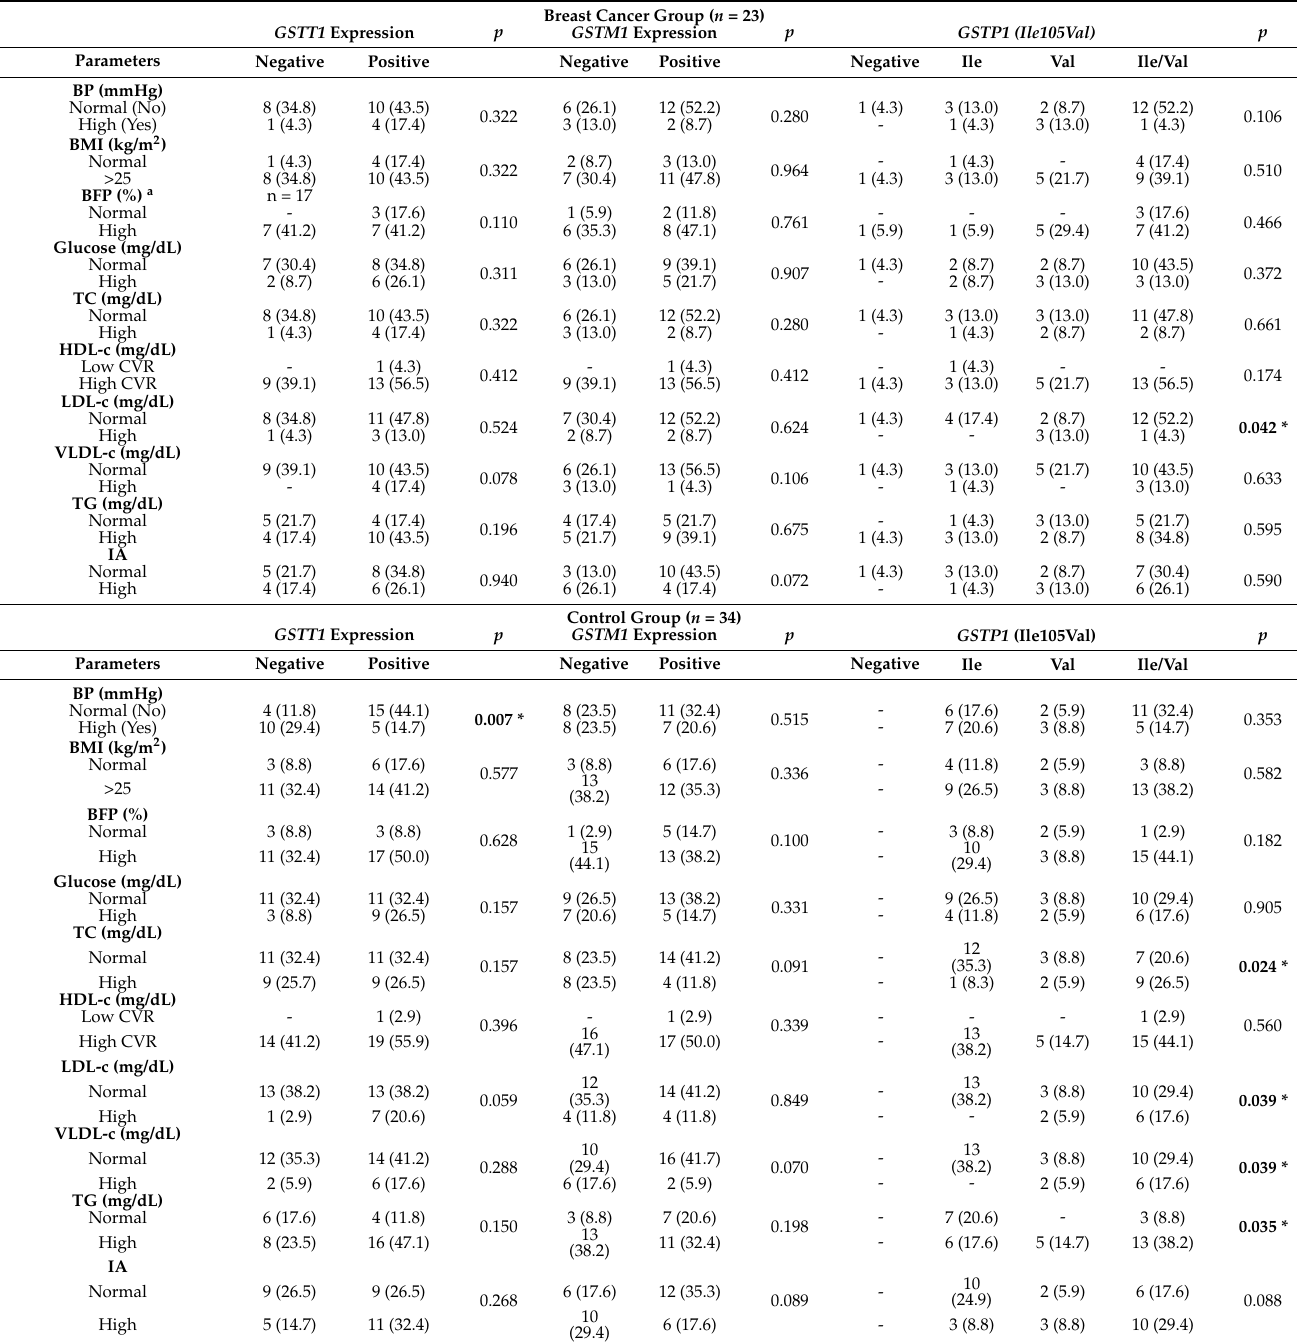
Table 5. Categorized clinical, biochemical and body composition parameters according to GST expression among participants by study